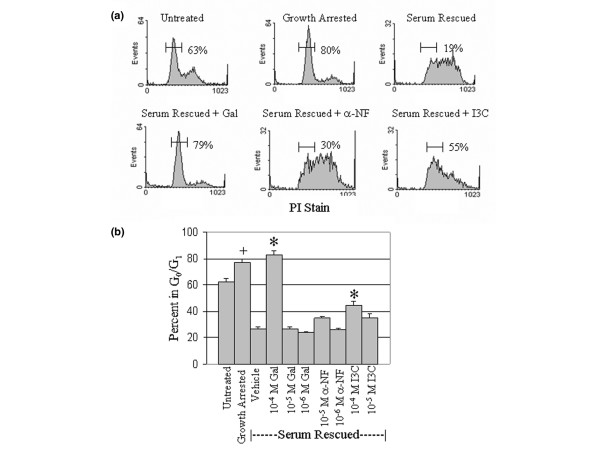
Galangin and indole 3-carbinol (I3C) block Hs578T cells progression from G0/G1 into cell cycle. Hs578T cells were synchronized by serum deprivation for 48 h followed by rescue with 10% serum. As indicated, 10-4 to 10-6 M galangin (Gal), 10-5-0-6 M α-naphthoflavone (α-NF), or 10-4 M I3C were added to triplicate wells at the time of serum rescue. Cells were harvested 24 hours later and assayed for DNA content by propidium iodide (PI) staining and flow cytometry. Data from triplicate wells were averaged in each experiment. (a) Flow cytometry histograms from one representative experiment in which 10-4 M galangin, 10-5 M α-NF, and 10-4 M I3C were used are presented. (b) Data pooled from 4 to 9 experiments are presented as the mean percentage of cells in G0/G1 + standard error. An asterisk (*) indicates a significant increase relative to serum starved, vehicle treated cultures, p < 0.01. A cross (+) indicates a significant increase relative to untreated cultures, p < 0.01.